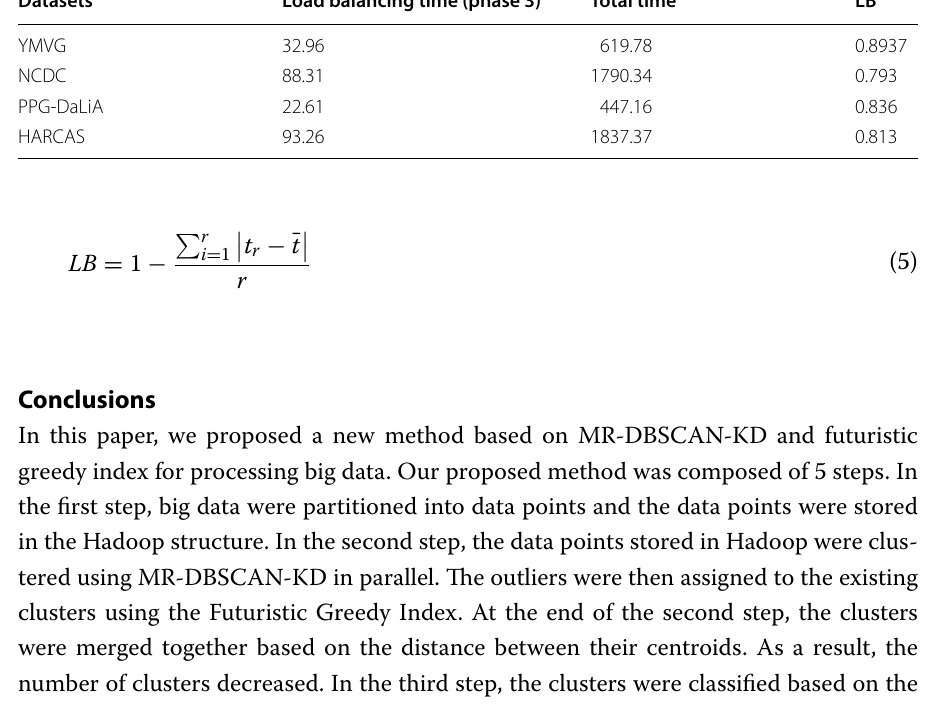
Table 6 Correlation between load balancing and total execution time